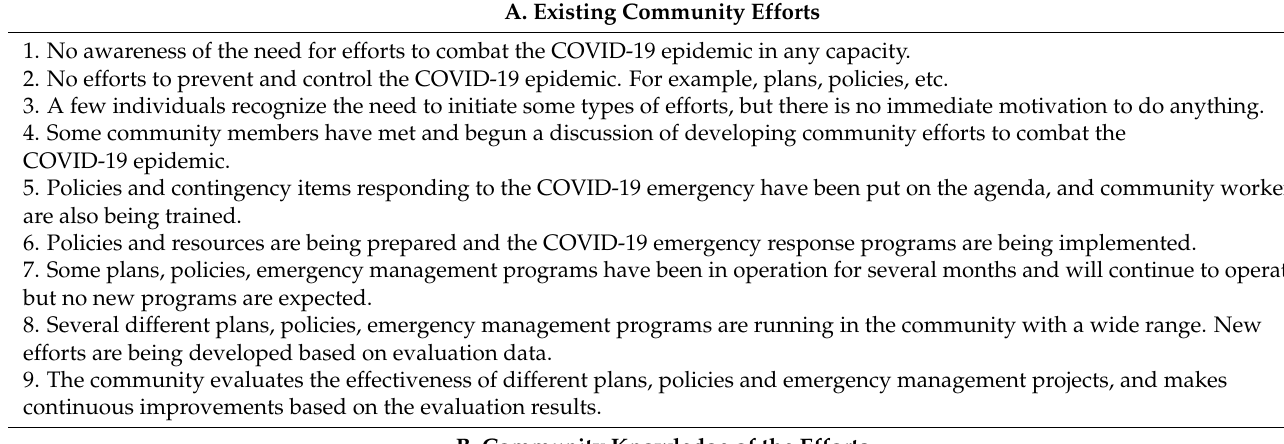
Table 3. Anchor rating